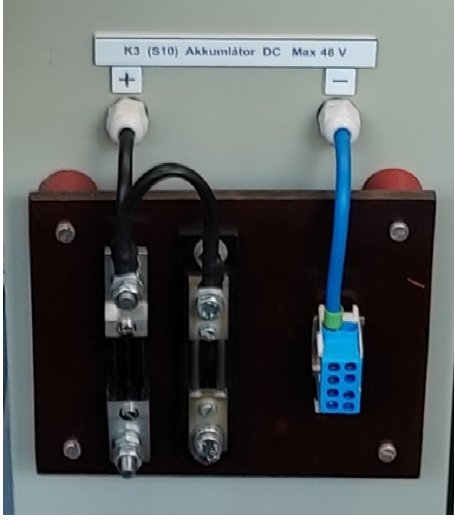
Figure 6. Shunt resistors for measuring the electric current intensity.